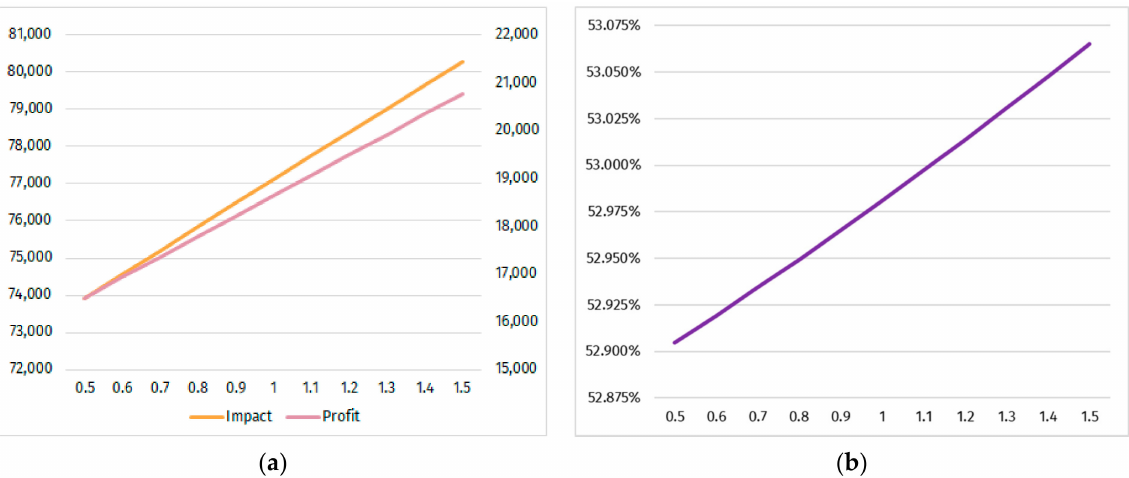
Figure 8. Results under varying demand parameters: ( a ) Profit and environmental impact optimal values under varying demand; ( b ) objective function efficiency values under varying